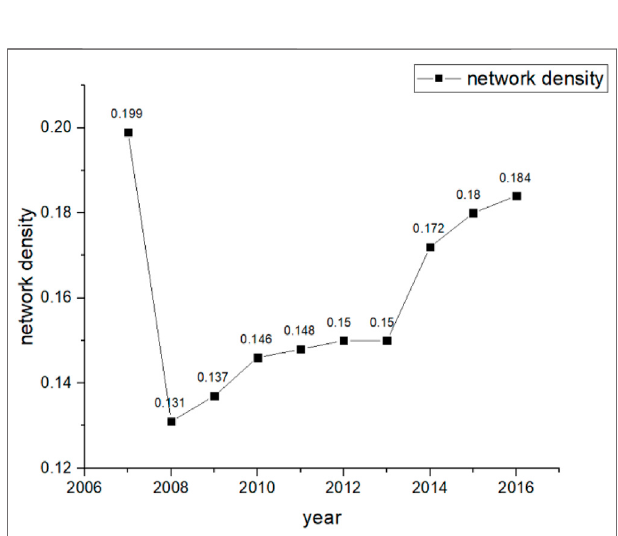
FIGURE 2 | Network density from 2007 to